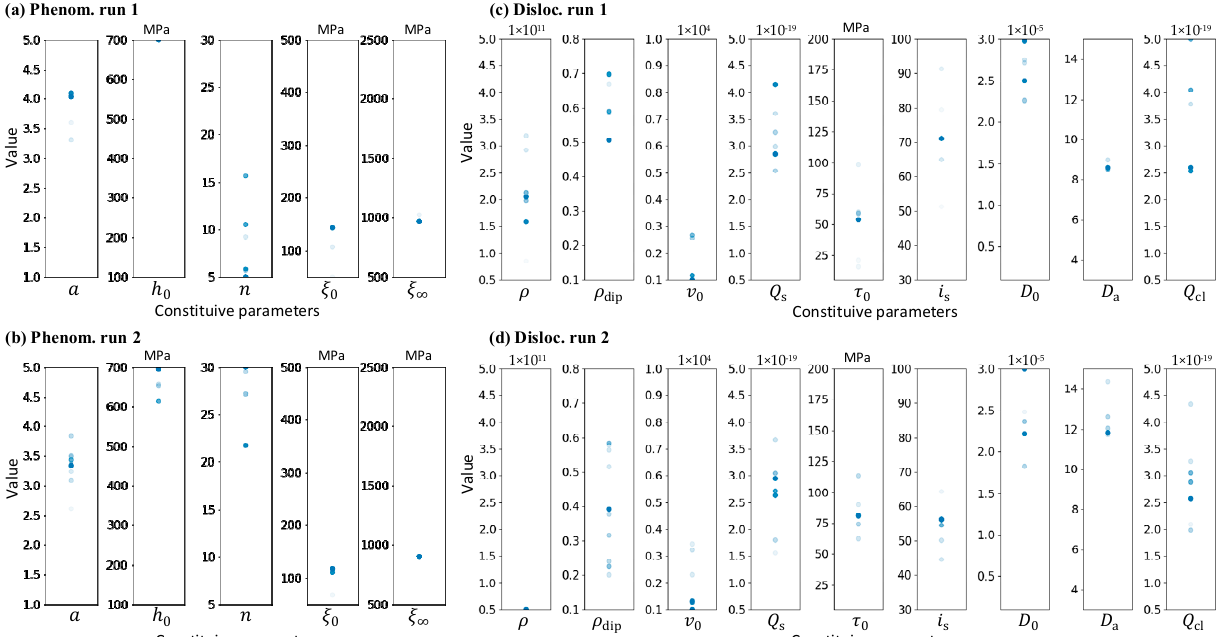
Figure 14. The parameter distribution of the candidate solutions in the last generation in ( a ) phe- nomenological model run 1, ( b ) phenomenological model run 2, ( c ) dislocation density model run 1, and ( d ) dislocation density model run 2. The semitransparent blue points represent the certain constitutive parameters of solutions in the last generation, overlap points will show deeper color.